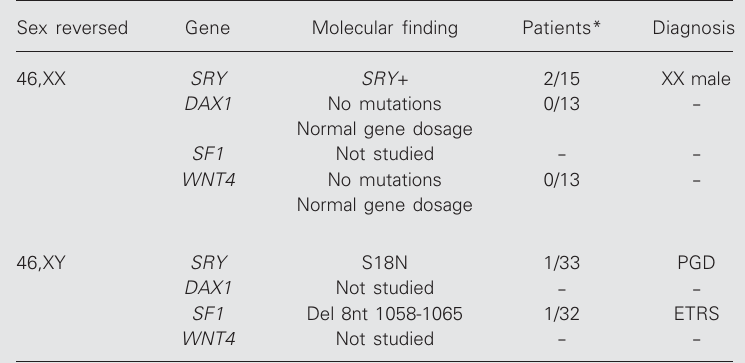
Table 1. Molecular findings of SRY , DAX1 , SF1 and WNT4 genes in Brazilian sex- reversed patients.